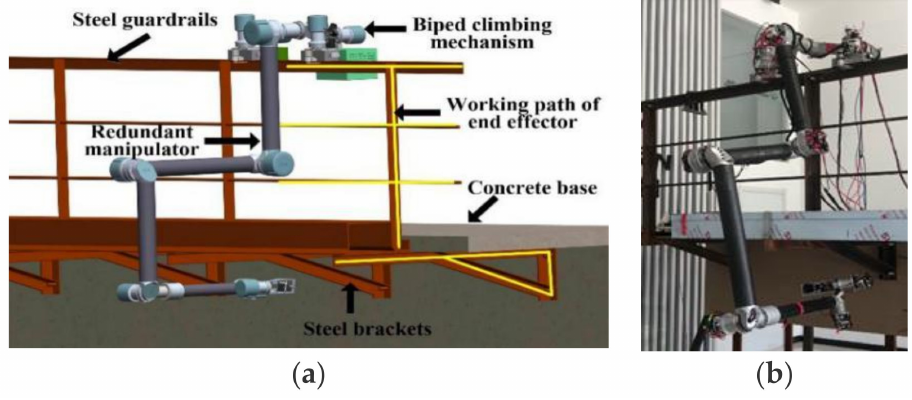
Figure 1. Overall structure of the CMBOT. ( a ) Sketch of the CMBOT, ( b ) Prototype of the